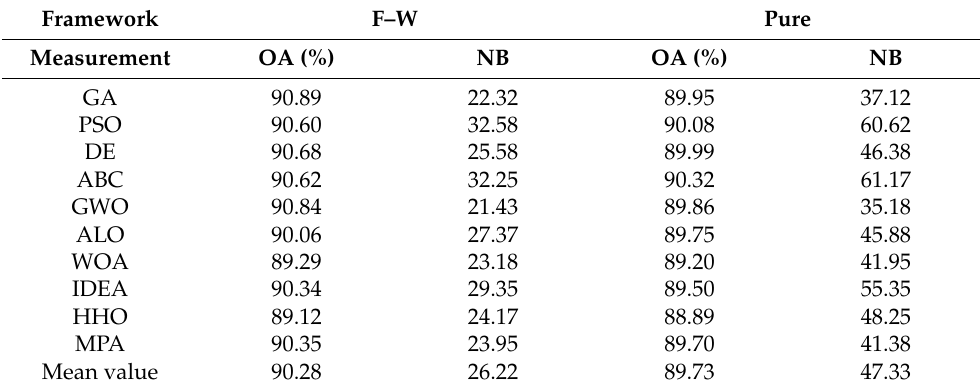
Table 5. The mean value of different algorithms on the three datasets.